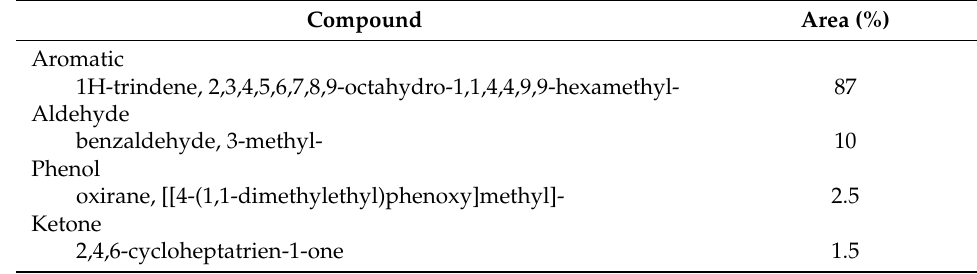
Table 3. Composition of soluble coke by GC-MS analysis on Co/NaX after a typical reaction.